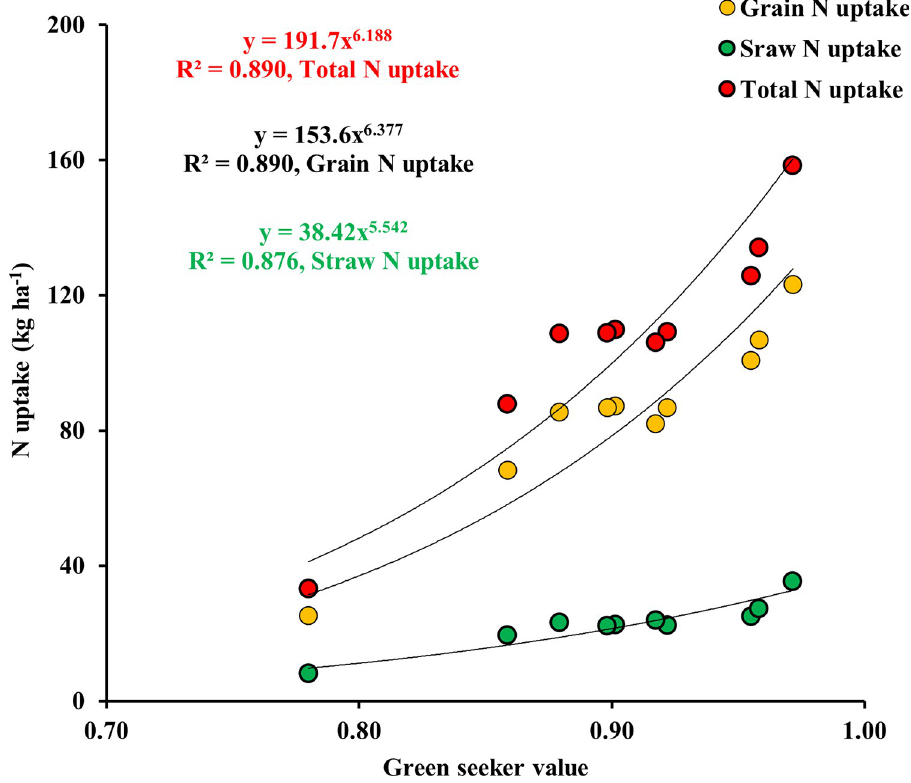
Fig 6. Quantitative relationship between Green seeker value and N uptake by grain, straw and total (grain + straw) N uptake by wheat ( Triticum aestivum L.) in a sandy loam soil.